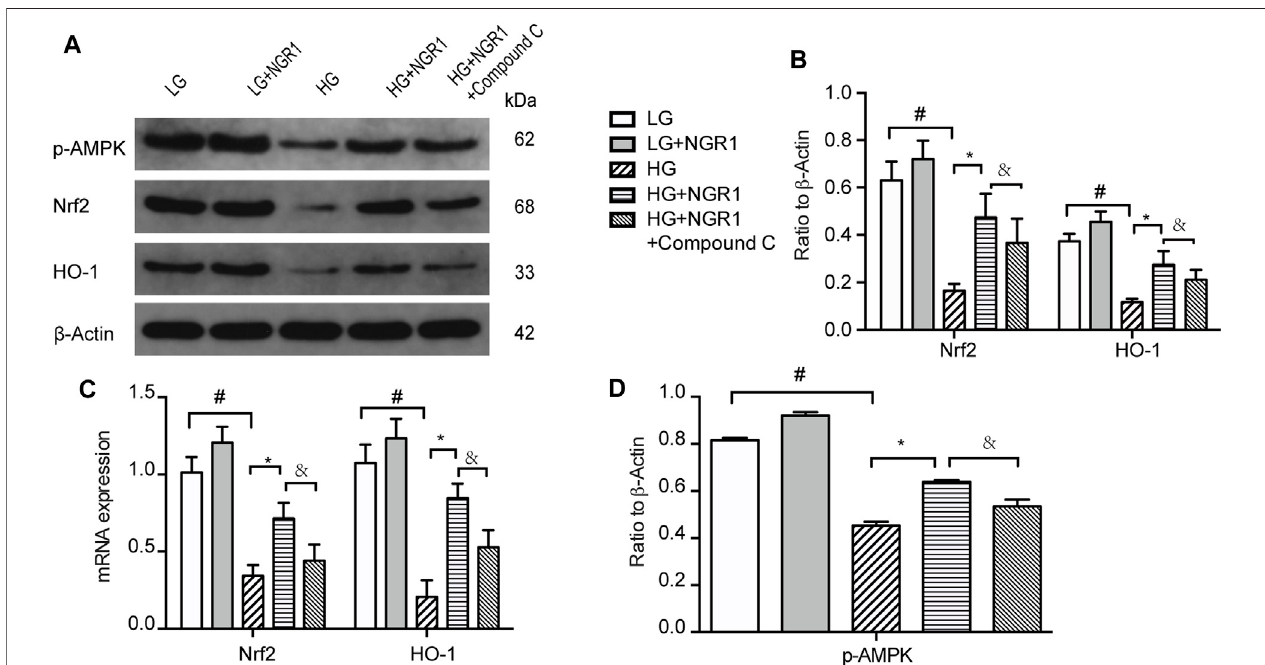
FIGURE 4 | NGR1 activates Nrf2 signaling and HO-1 expression via activation of the AMPK pathway (A) Expression of Nrf2 and HO-1 protein in H9c2 cells by Westernblotanalysis. (B) DensitometricanalysisofNrf2and HO-1 expression. (C) Nrf2and HO-1 mRNAexpression (D) Expressionof p -AMPKprotein inH9c2 cellsby Westernblotanalysis.Dataareshown asthemean ± SEMofthreeindependentexperiments, * p < 0.001, & p < 0.001,and # p < 0.001.LG,5.5 mMglucose; HG,30 mM glucose; NGR1, Notoginsenoside R1.